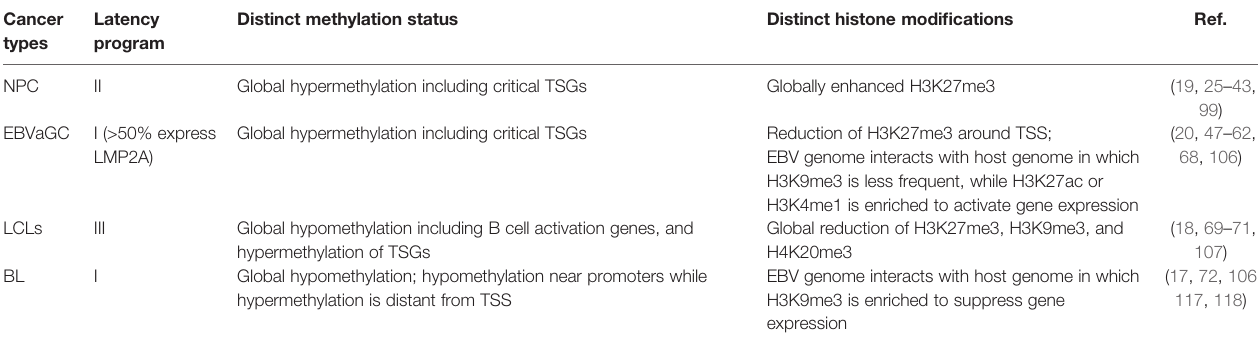
TABLE 1 | Methylation and histone modi fi cation features for NPC, EBVaGC, LCLs, and